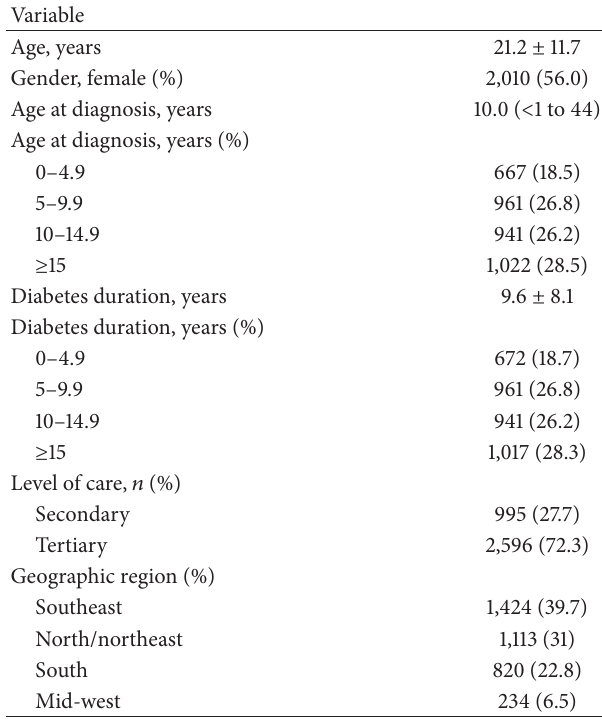
Table 1: Demographic data of the studied